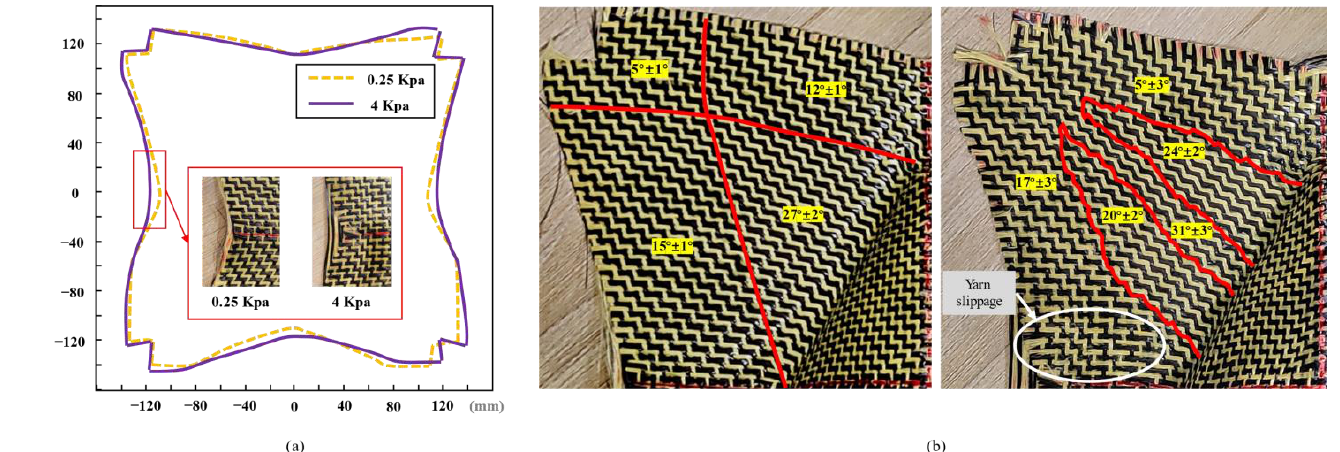
Figure 18. 0 ◦ /90 ◦ tetrahedral preforms under different blank holder pressures. A decrease in material draw-in and an uncertain change in shear angle distribution occur at high pressure: ( a ) material draw-in comparison; ( b ) shear angle distribution of non-useful areas under 0.25 Kpa (left) and 0.4 Kpa (right) blank holder pressure.